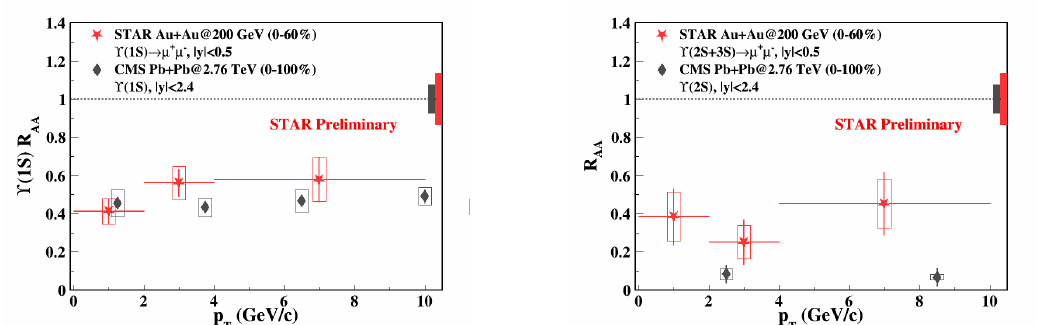
√ s NN = √ s NN = 2.76 TeV